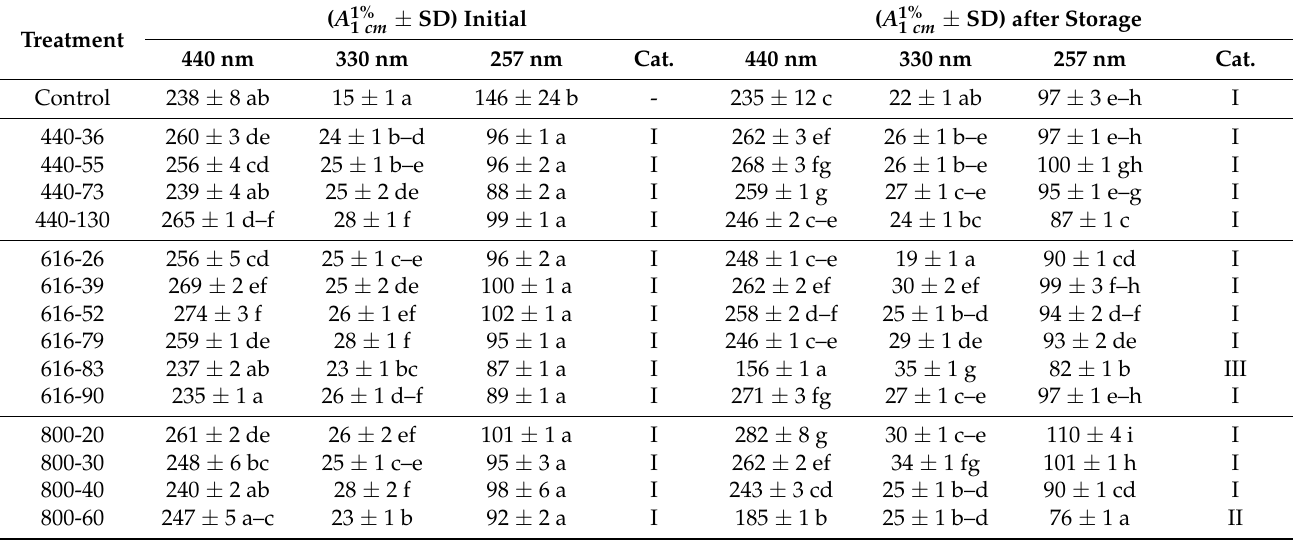
Table 6. UV-vis spectrophotometric parameter values of saffron samples obtained under different microwave dehydra- tion